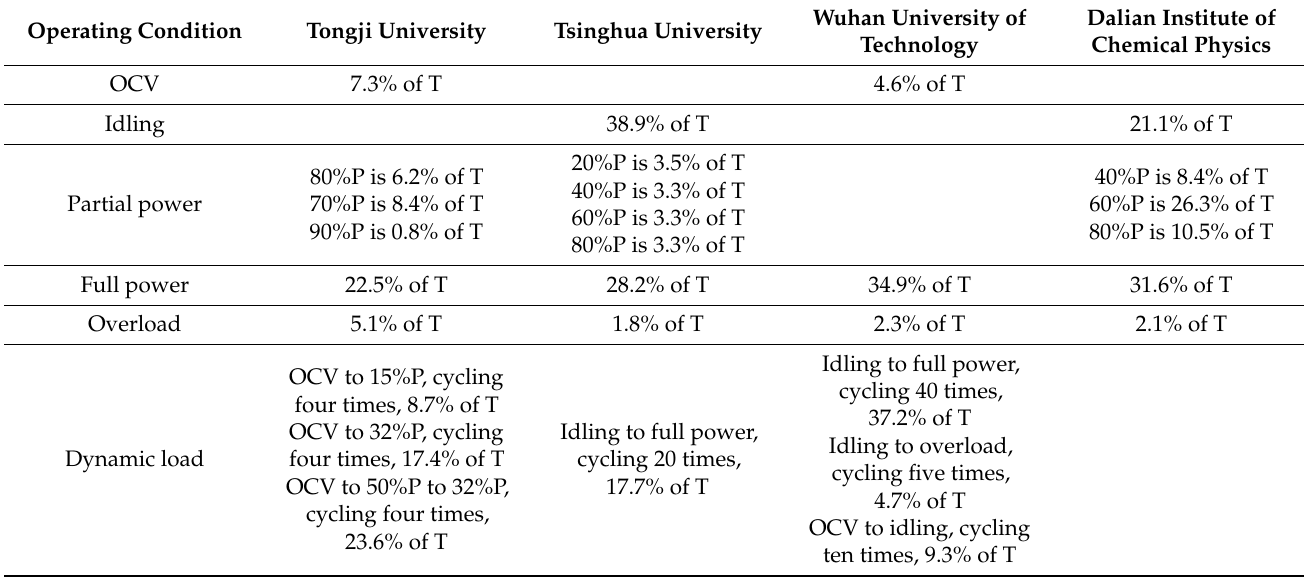
Table 6. Comparison of PEMFC durability test protocol of universities and institutes in China [4] (P—rated power, T—whole duration) (Reproduced with permission from Huicui et al. [4], Applied Energy; published by Elsevier Ltd., 2018). Operating